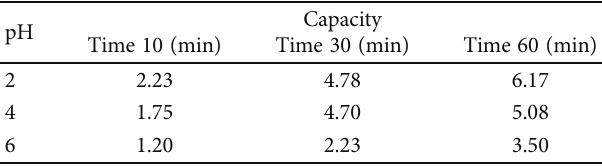
Table 2: The amount of cadmium that was adsorbed with the change of the acidity function and the immersion time in a solution of concentration 30 ppm.